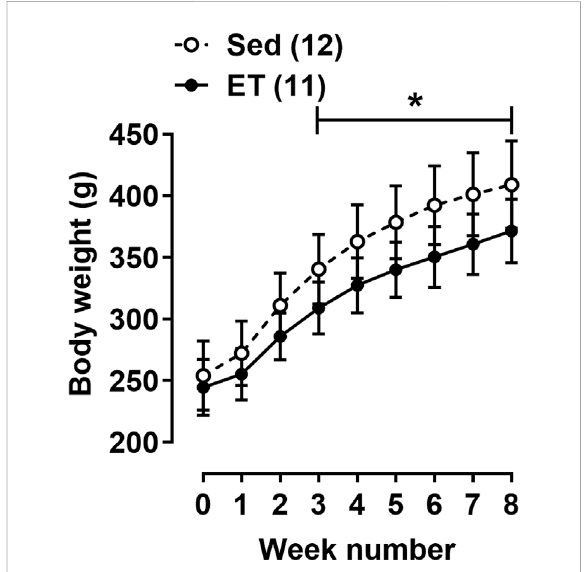
FIGURE 2 Body weight dynamics of rats during the experiment. Values at week “ 0 ” were obtained at the fi rst day of the training cycle. Sed – sedentary group of rats; ET – exercise-trained group of rats; number in parentheses indicates the number of animals. * p < 0.05 compared to the sedentary group (two-way ANOVA with Sidak ’ s multiple comparisons test).